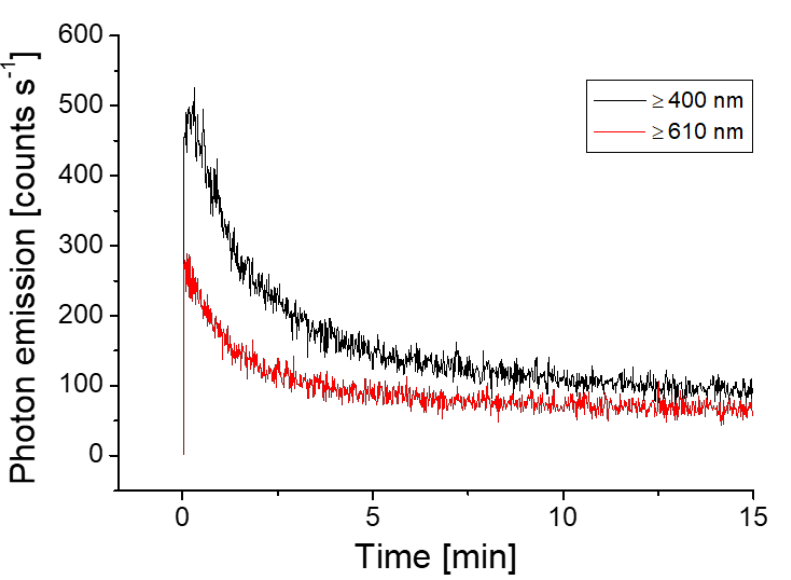
Figure 5 . Kinetics of ultra-weak photon emission measured 20 s after the mechanical wounding in the the presence of cut-on filters ≥ 400 nm and ≥ 610 nm. Other experimental conditions as described in presence of cut-on filters ≥400 nm and ≥610 nm. Other experimental conditions as described in Figure 3. Figure